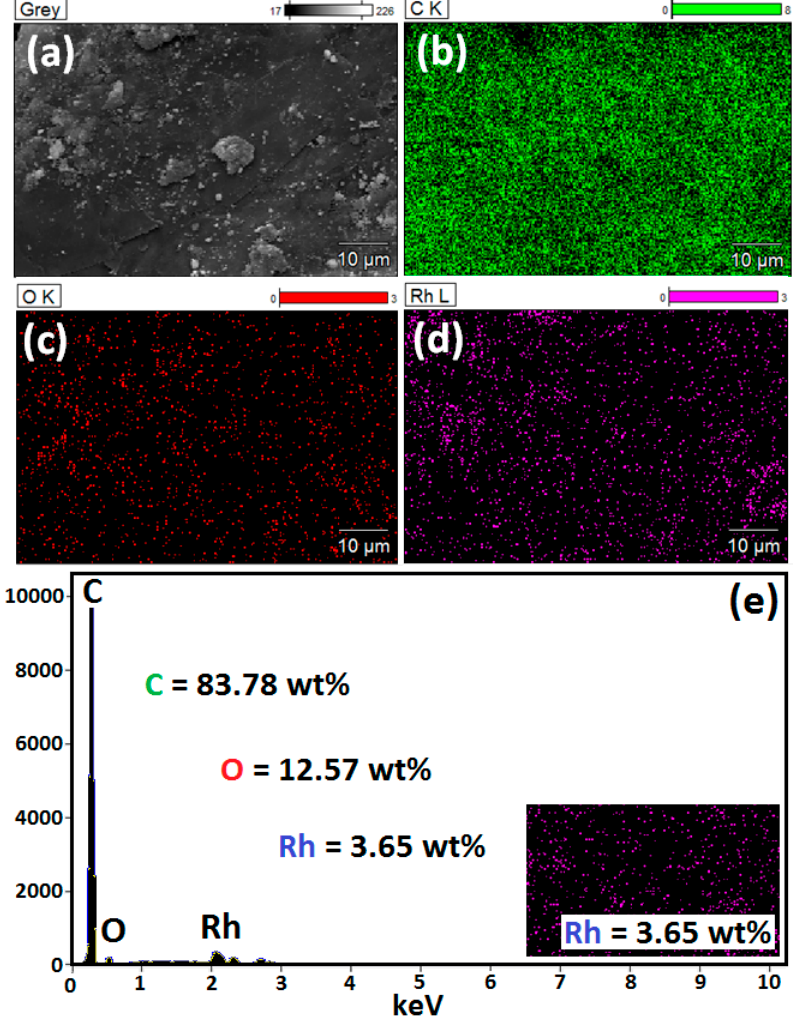
Figure 3. ( a ) Scanning electron microscope (SEM) image of Rh(0)NCs/GNPs and corresponding ( e ) energy dispersive spectroscope (EDS) spectrum and elemental mapping of ( b ) C, ( c ) O, and ( d )